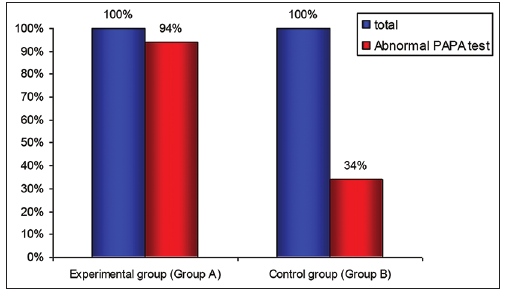
Figure 1. PAP test results in experimental and control group.